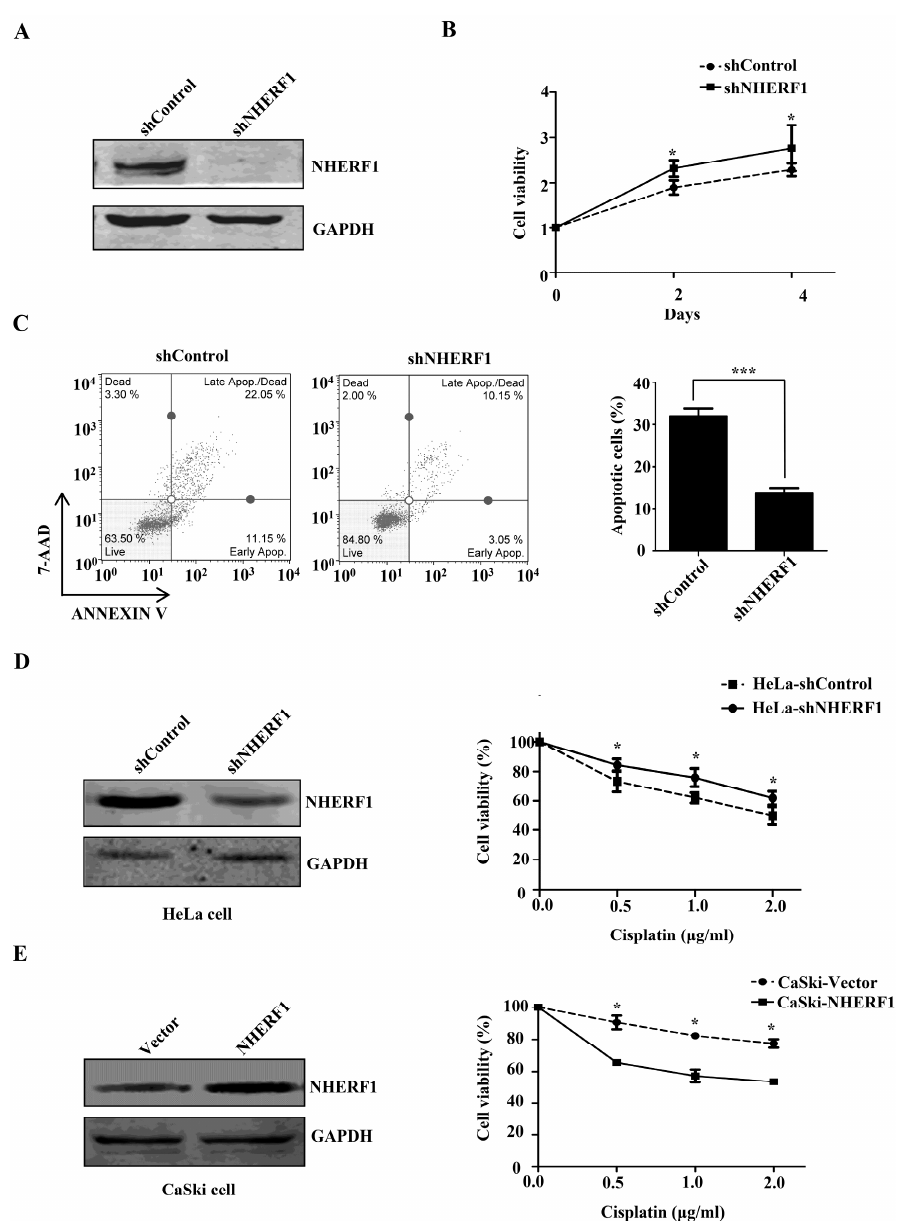
Figure 3. NHERF1 regulates cisplatin sensitivity in cervical cancer cells. ( A – C ) Effect of NHERF1 knockdown on cellular function in cisplatin-resistant HeLa cells. ( A ) Western blotting analysis of NHERF1 expression in cisplatin-resistant cells transfected with either control or NHERF1 shRNA; ( B ) Control or NHERF1 shRNA-transfected cisplatin-resistant HeLa cells were respectively cultured in 96-well plates and stained with CCK8 at 0, 2, 4 days. Growth of control and NHERF1 shRNA-transfected cells was assessed by measuring absorbance at 450 nm. Values are presented relative to cell viability on day 0. Data represent the mean ± SD of three individual experiments; ( C ) Cisplatin-resistant HeLa cells transfected with either control or NHERF1 shRNA were stained with 7-AAD and Annexin V. The percentage of cells in apoptotic phase was quantified with Muse™ Cell Analyser ( left panel ). Data represent the mean ± SD of three individual experiments ( right panel ); ( D ) Effect of NHERF1 knockdown on cisplatin sensitivity in parental HeLa cells. shRNA-transfected HeLa cells were incubated for 48 h upon cisplatin treatment; ( E ) Effect of NHERF1 overexpression on cisplatin sensitivity in CaSki cells. Control vector or NHERF1-transfected cells were incubated for 48 h in the presence of cisplatin. In ( D ) and ( E ), left panel: Western blotting analysis of NHERF1 expression. Right panel: Cell viability analyzed by measuring absorbance at 450 nm. Values are presented relative to cell viability in the absence of cisplatin. Data represent the mean ± SD of three individual experiments. * p < 0.05, *** p < 0.001 compared with control cells.